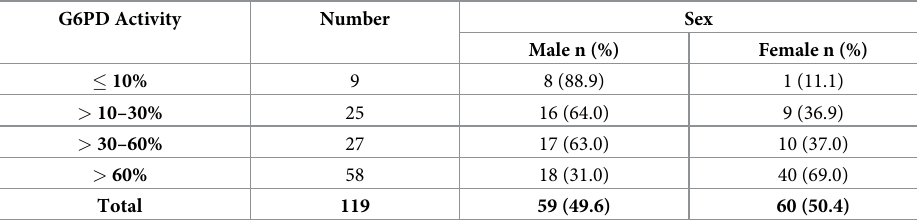
Table 3. Distribution of G6PD enzyme activity, analysed by spectrophotometry, according to